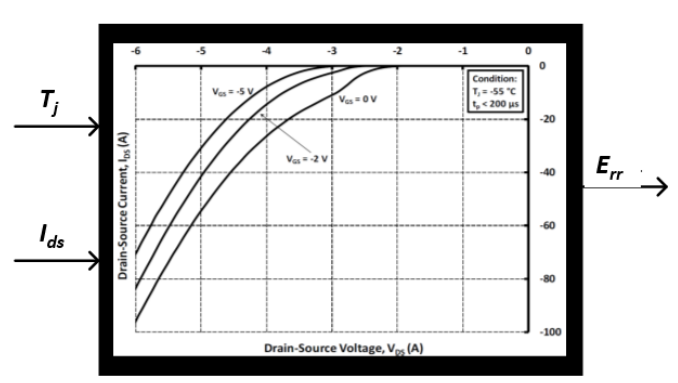
Figure 14. Lookup table to determine diode E rr .